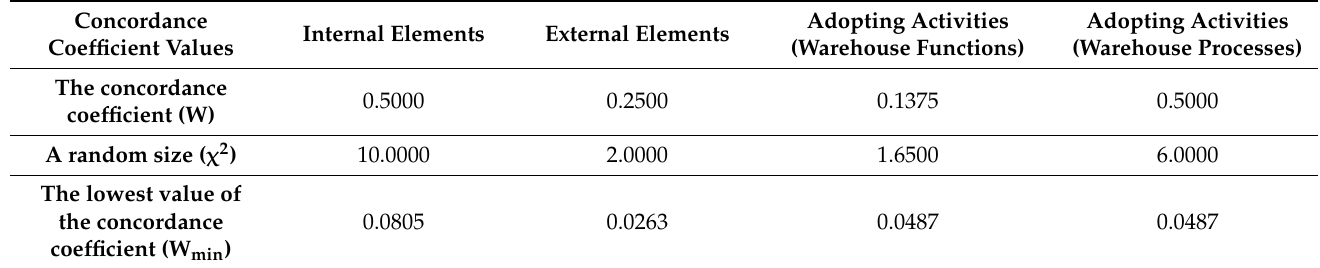
Table 11. Concordance coefficient.